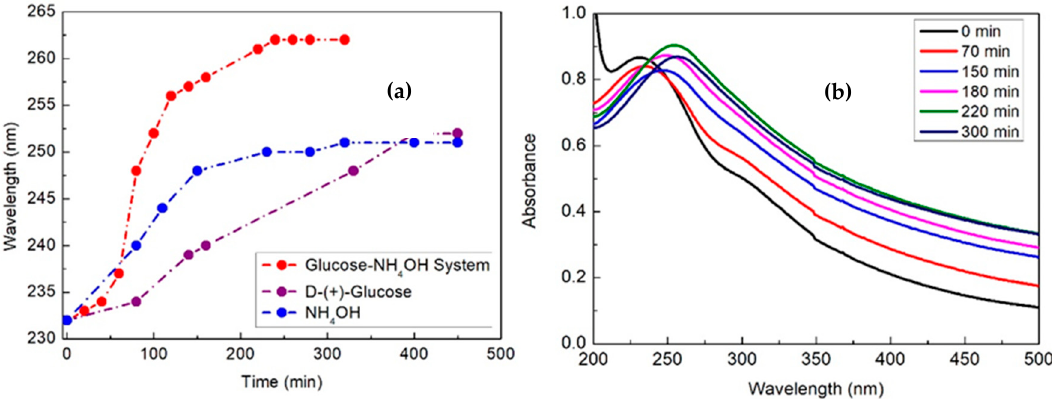
Figure 2. ( a ) Wavelength changes of the maximum peak in the three different operative conditions and ( b ) Uv-Vis spectral change during the reduction of graphene oxide in the glucose-NH 4 OH system, as function of reaction time.